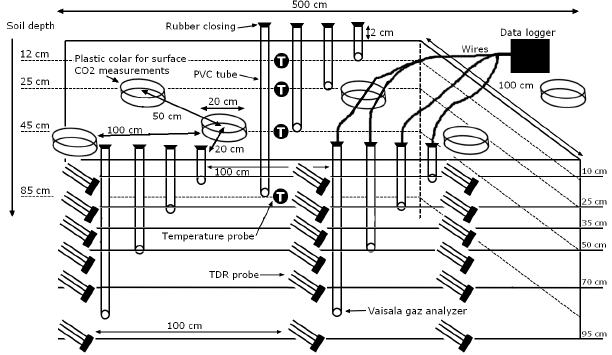
Figure 4. Schematic description of the experimental plot (sampling design) at each slope position showing how temperature, VWC, CO 2 concentrations and CO 2 fluxes probes collocate with each oth- ers. Probes have been inserted at different locations both vertically and horizontally. Consequently, all of them are not in the same plane (i.e. depth lines with axes labels on the right hand-side illustrate the foreground profile and depth lines with axes labels on the left hand- side illustrate the background